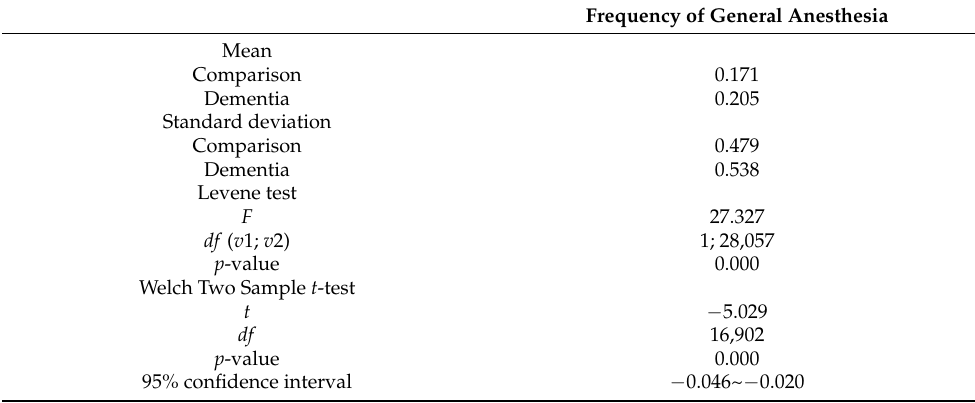
Figure 4. Cumulative hazard plots for specific diseases between patients who underwent general anesthesia and without anesthesia experience: ( A ) Alzheimer’s disease. ( B ) Vascular dementia. Table 7. Welch two sample t -test comparisons between the dementia and comparison